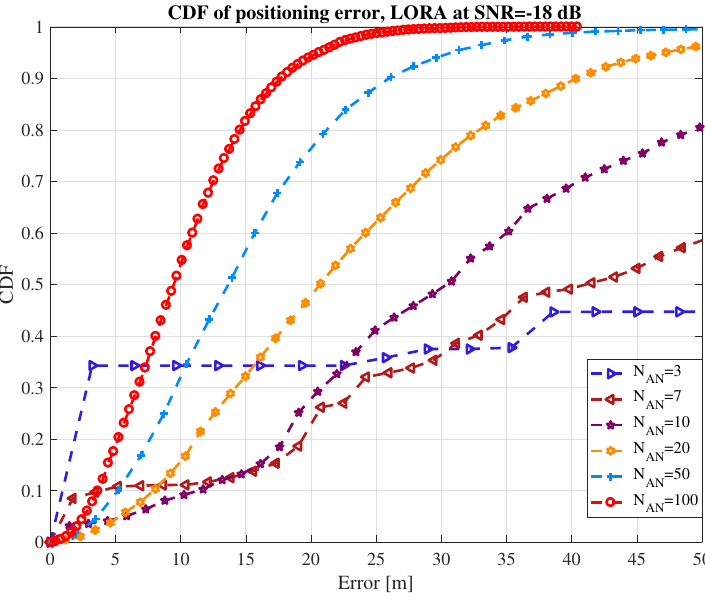
Figure 7. Example of LoRa performance at various numbers of access